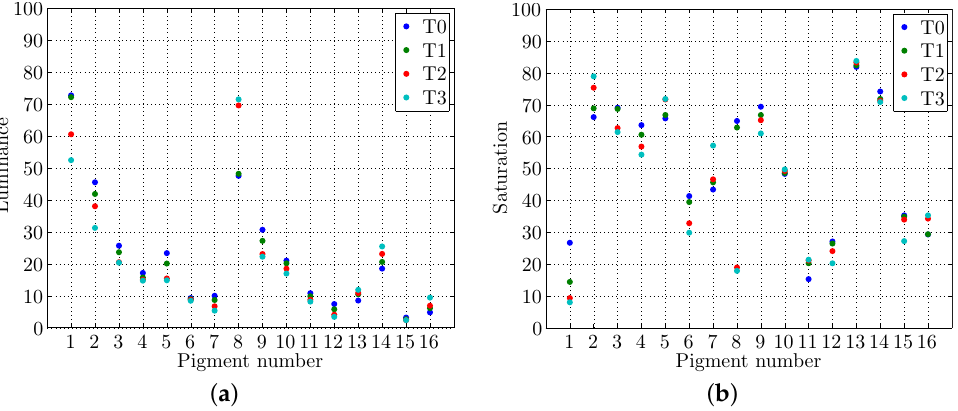
Figure 6. ( a ) Lightness and ( b ) saturation at different aging steps for the fundamental pigments of Section